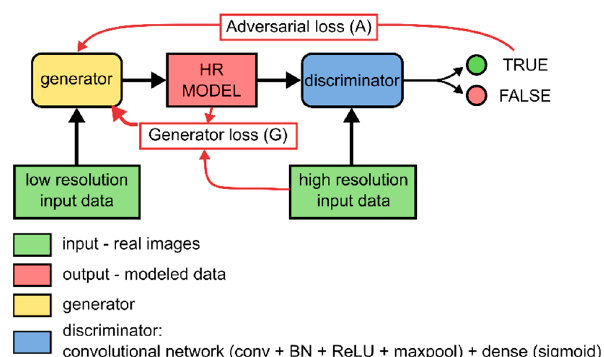
Figure 2. Conditional generative adversarial network (C-GAN) which was used for the super-resolution task in this research. A C-GAN consists of two neural networks, the generator and discriminator. The generator corresponds to the fully convolutional Residual U-Net shown in Figure 1 and the discriminator is a convolutional network combined with a dense network tasked to classify real and “fake” images. The goal of this C-GAN is to train the generator to simulate high-resolution (HR) equivalents of low-resolution (LR) input volumes by training using a generator and an adversarial loss.